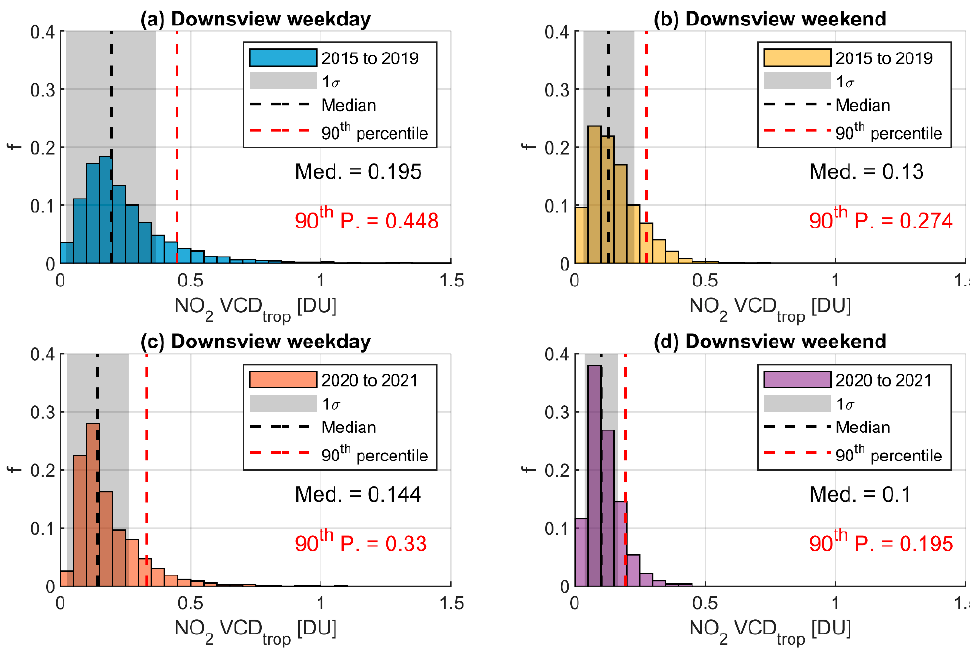
Figure 3. Histograms of NO 2 tropospheric column at Downsview site for observations from 15 March to 15 September for each year. ( a , b ) show weekday and weekend observations before the pandemic (2015–2019), respectively; ( c , d ) show weekday and weekend observations during the pandemic (2020–2021), respectively. The vertical black dashed line shows the median value of tropospheric NO 2 with shading area representing its standard deviation. The vertical red dashed line shows the 90th percentile of observed tropospheric NO 2 .